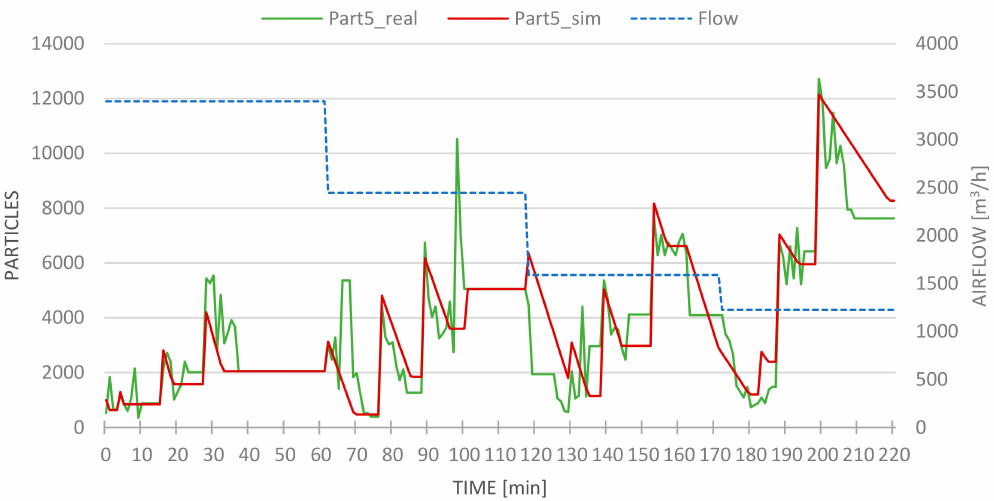
Figure 7. Simulated particles Size: 5 µ m. Red line: simulated particles. Green line: real particles. Blue line: